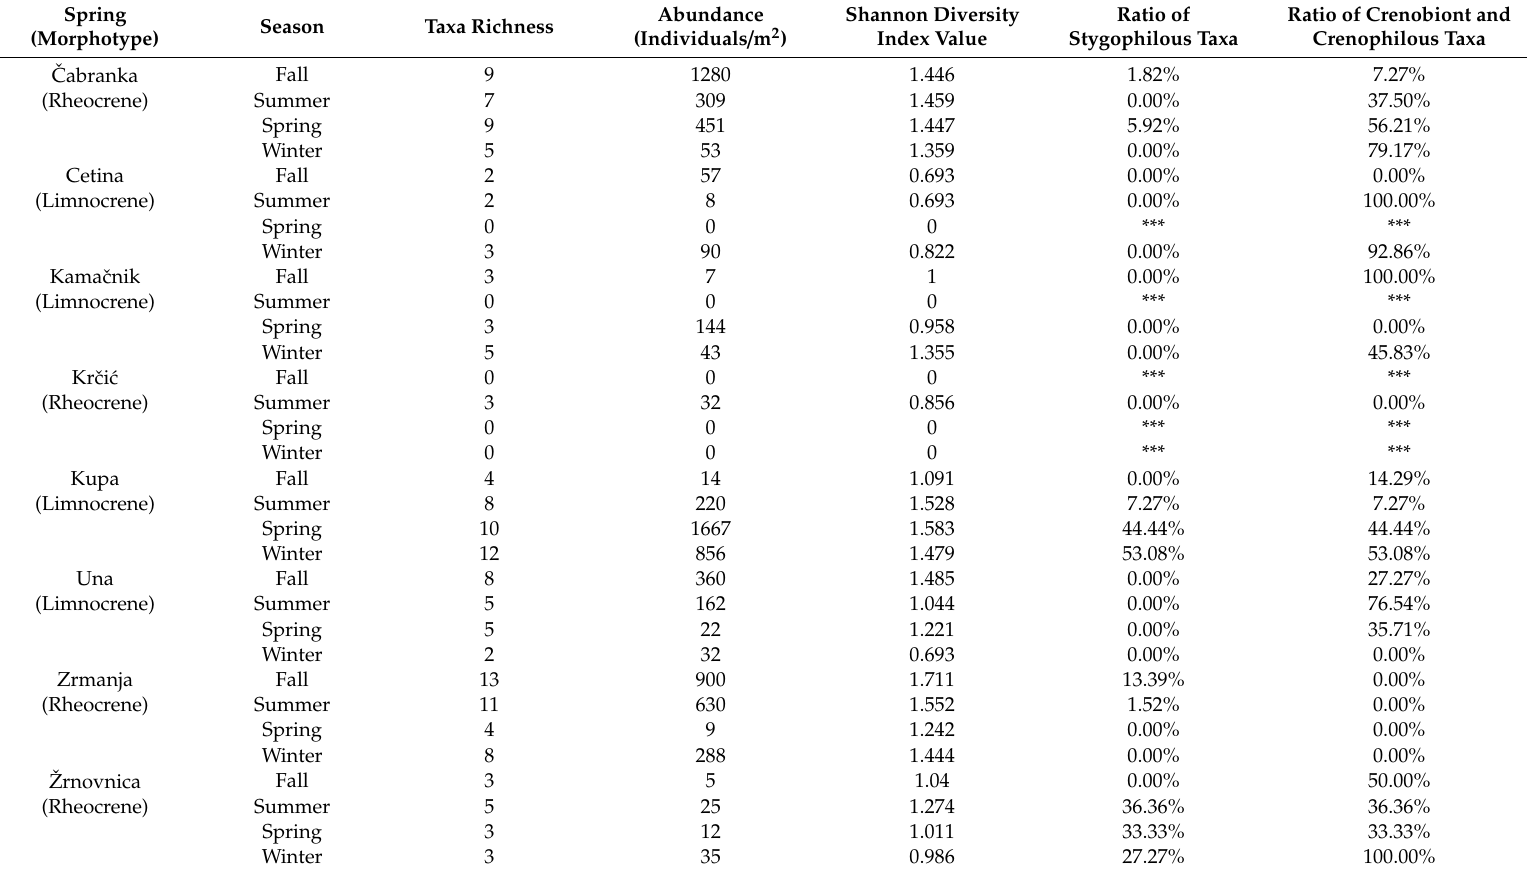
Table A4. Seasonal water mite taxa richness, abundance, Shannon diversity values and ratios of synecological (*** indicates no water mites present, whereas 0% indicates no taxa from synecological group present) water mite groups in the studied limnocrenes and